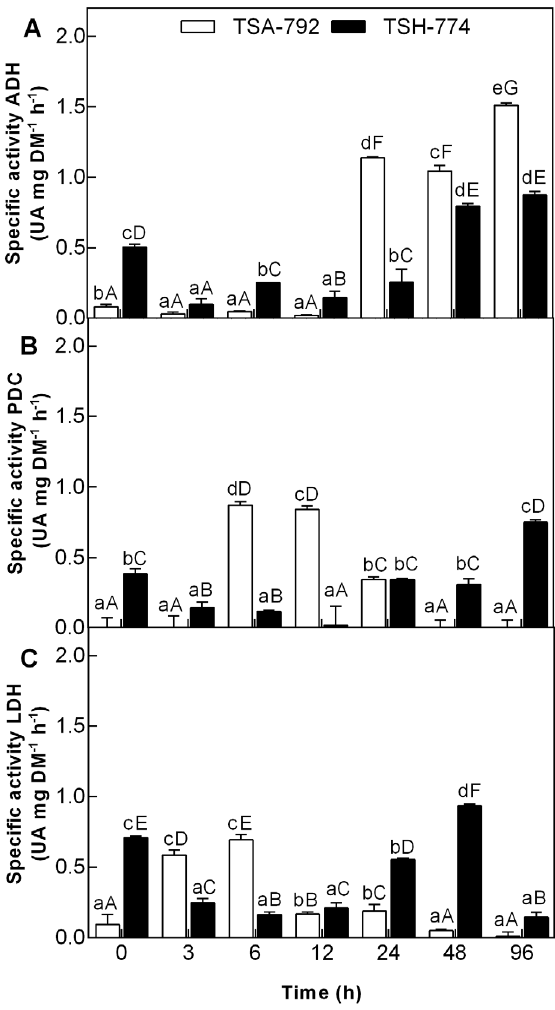
Figure 3. ADH activity (A), PDC (B) and LDH (C) in roots of plants of TSA-792 and TSH-774 clonal genotypes of Theobroma cacao subjected to soil flooding during periods of 0, 3, 6, 12, 24, 48 and 96 h. Lowercase letters compare between genotypes. Uppercase letters compare differences between genotypes and lower- case letters compare differences within genotypes. Mean comparisons were using a Tukey test (P , 0.05). UA - absorbance units.